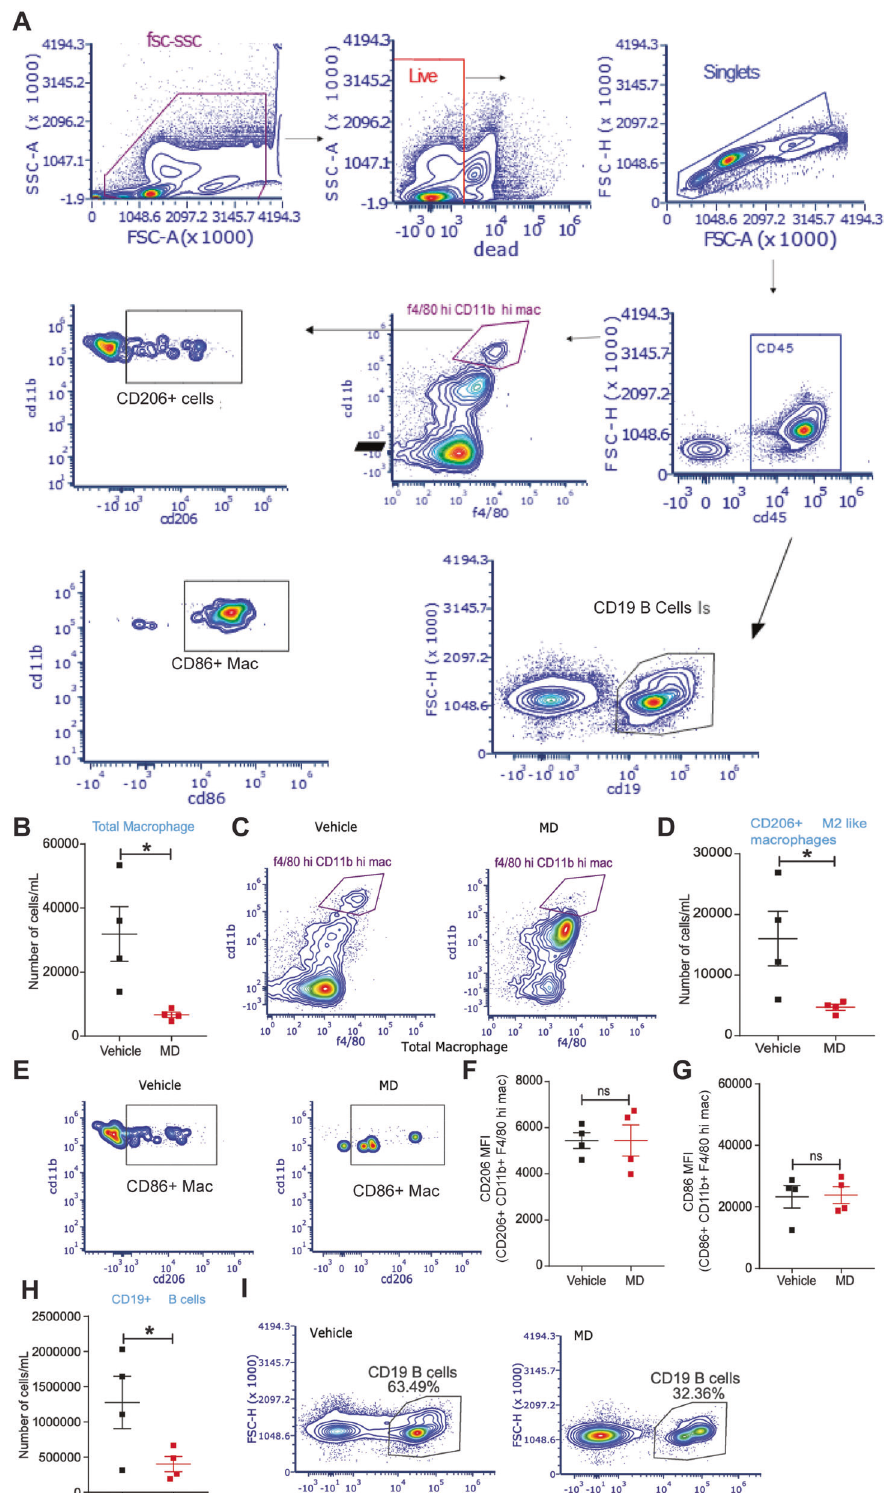
leucine, valine, threonine, lysine, glycerophosphatidylcholine, succinic acid and 2-hydroxybutyrate whereas levels of lipids, glucose, isoleucine, and arginine are reduced [50, 51]. Further, in another report, two metabolites triacylglycerols and α ‐ amino acids were found abundant in the serum of endometriosis patients